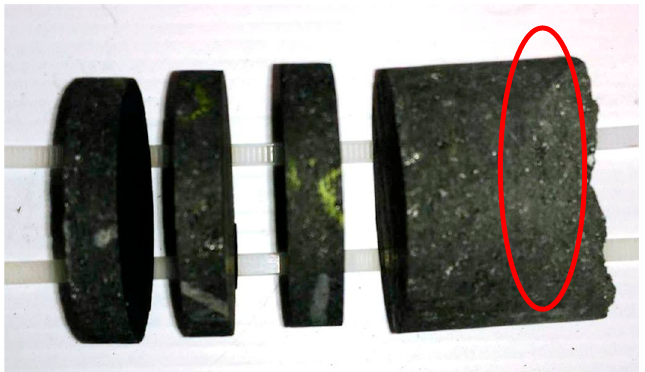
Figure 4. Broken sample prepared for measurement using the Van der Pauw method. The failure was circled at the right of the sample.